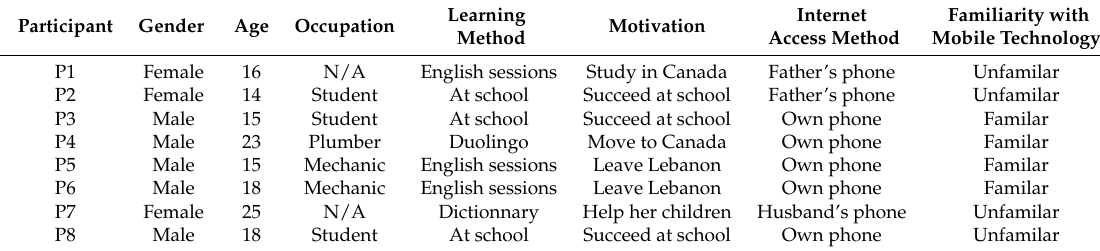
Table 1. How and why are the participants learning English in Lebanon.